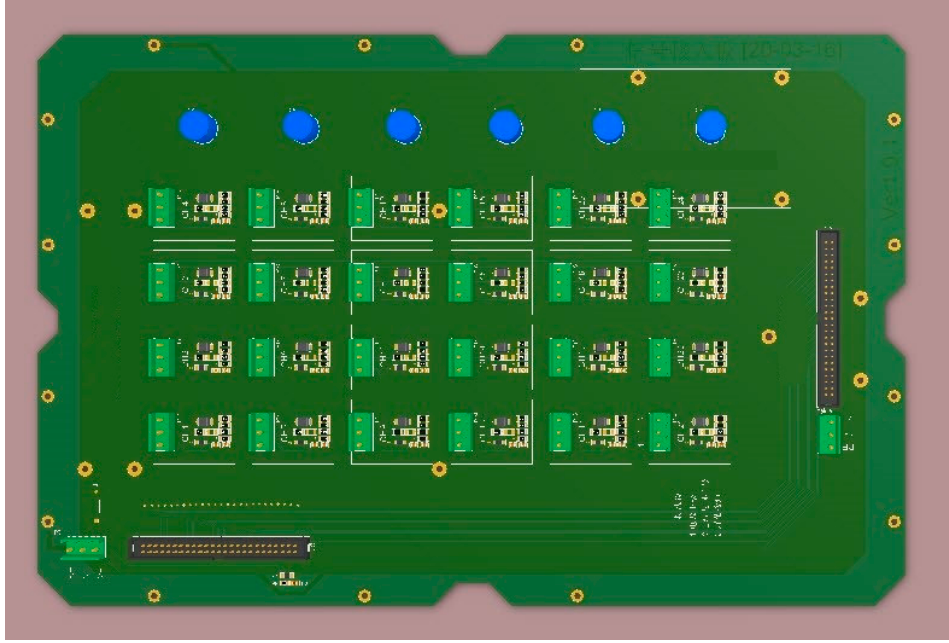
Figure 6. The acquisition board. The current signal output via multiple nodes on the acquisition board is converted into the voltage signal, as shown in Figure 7.